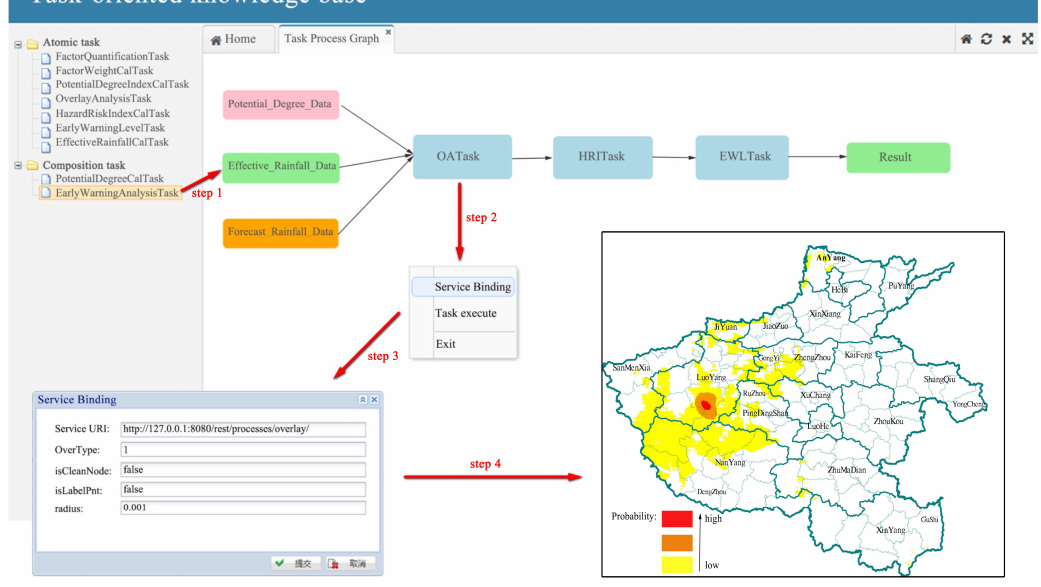
Figure 13. The graphical user interface of the prototype